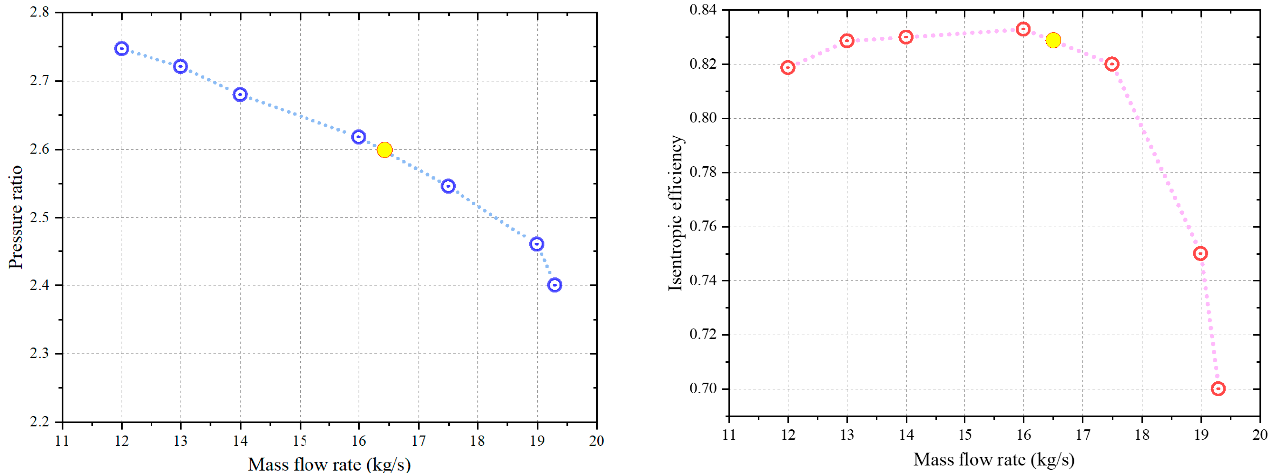
Figure 3. Performance curve of the single-stage compressor (@ 40,000 RPM).